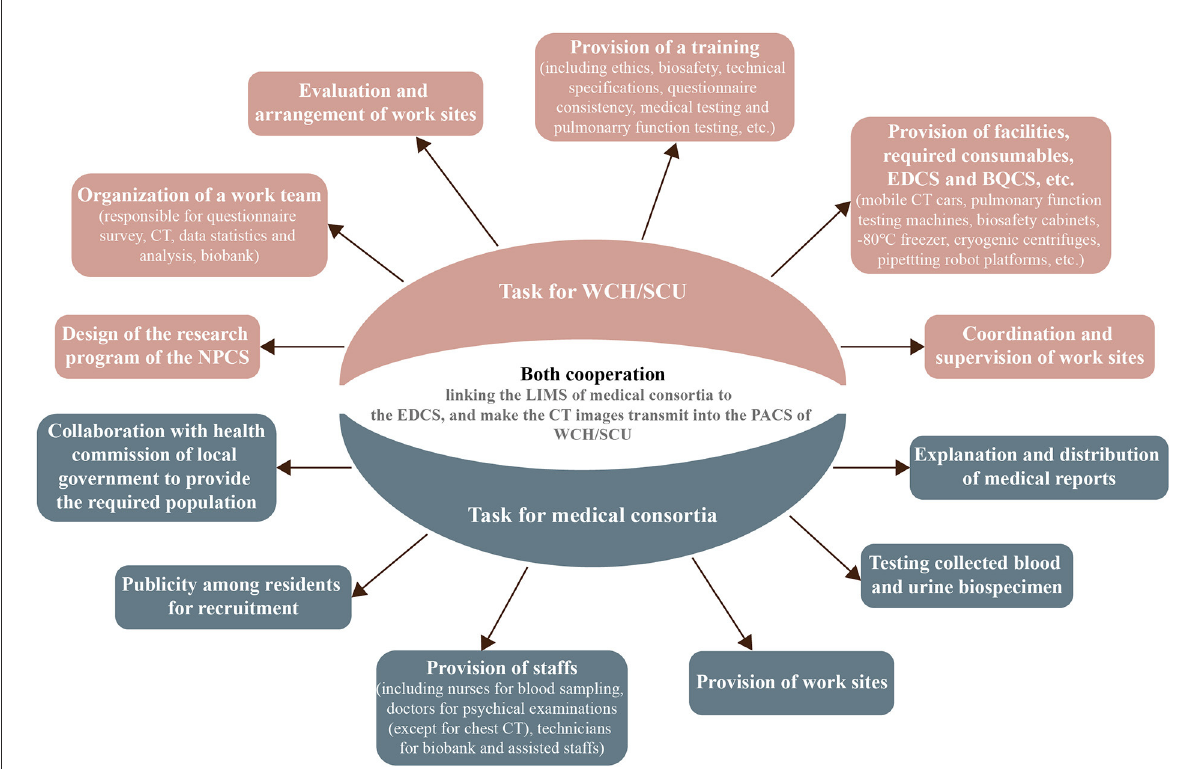
FIGURE2 Task for WCH/SCU and medical consortia. WCH/SCU, West China Hospital of Sichuan University; NPCS, natural population cohort study of west China Hospital of Sichuan University; EDCS, electronic data capture system; BQCS, biospecimen quality control system; LIMS, laboratory information management system; PACS, picture archiving and communication system.